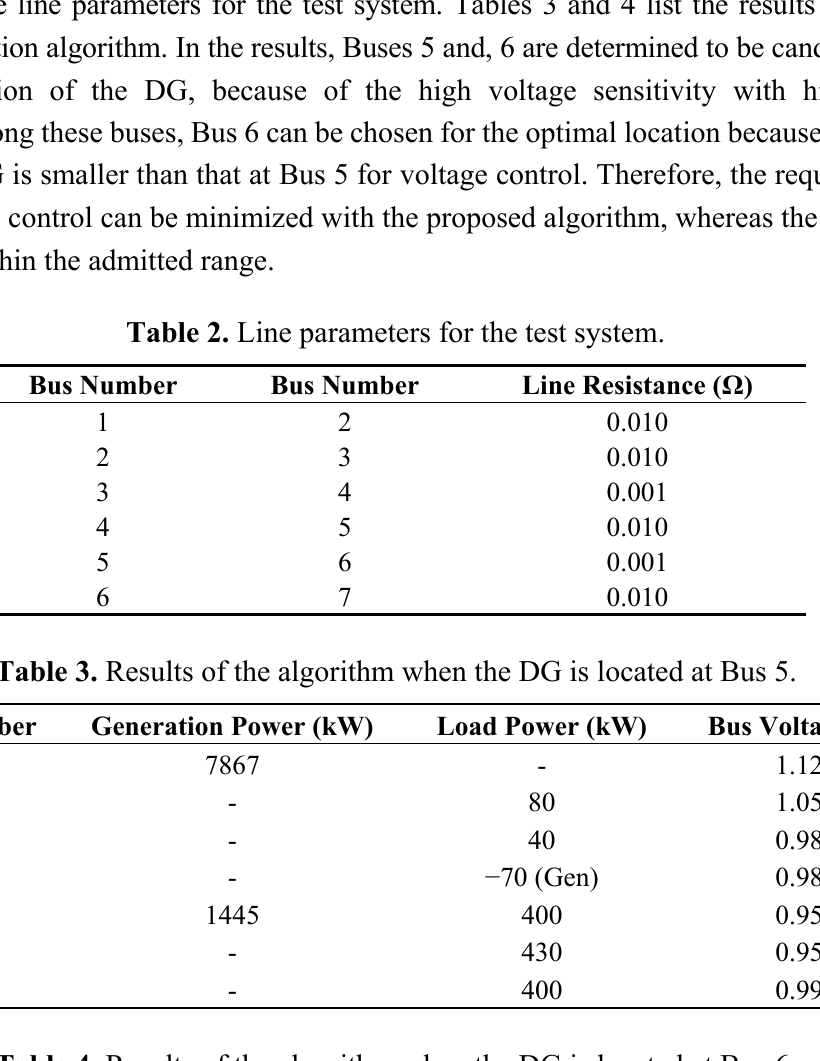
Table 4. Results of the algorithm when the DG is located at Bus